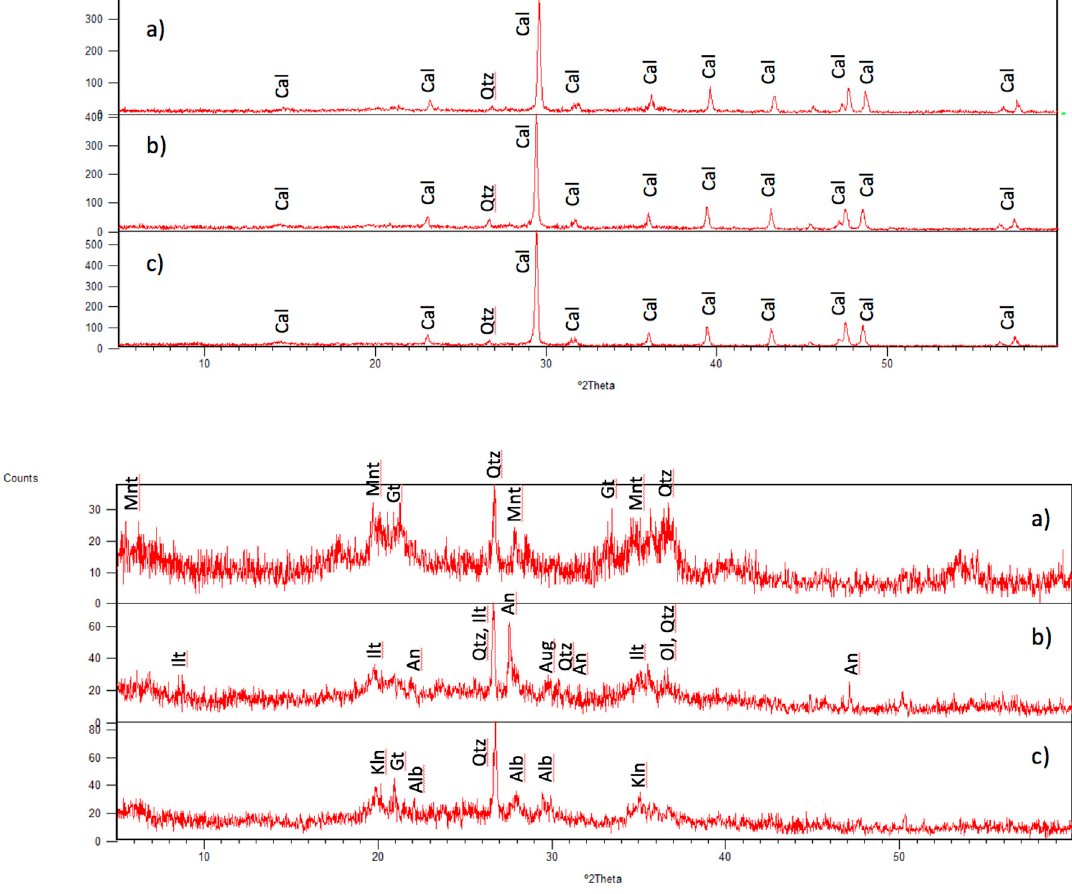
Figure 3. Whole XRD patterns of carbonated samples ( a ) GC-627-B-151, ( b ) GC-690-CC and ( c ) GC-681-B-190 before (upper) and after (lower) treatment with acetate buffer. (For mineral name abbreviations and d-spacing labelled as a plane direction of h k l see Table 2).